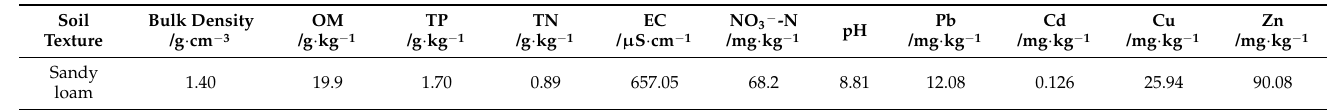
Table 2. Basic physicochemical properties of tested soil before the